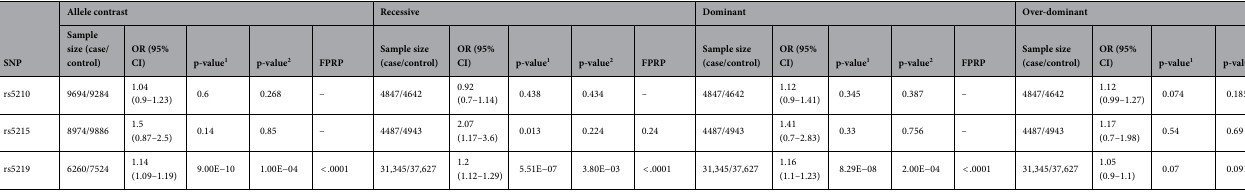
Table 2. Association meta-analysis of KCNJ11 polymorphisms in the general population. The FPRP analysis was done for the significant associations. The FPRP level of noteworthiness is 0.2 OR odds ratio, CI confidence